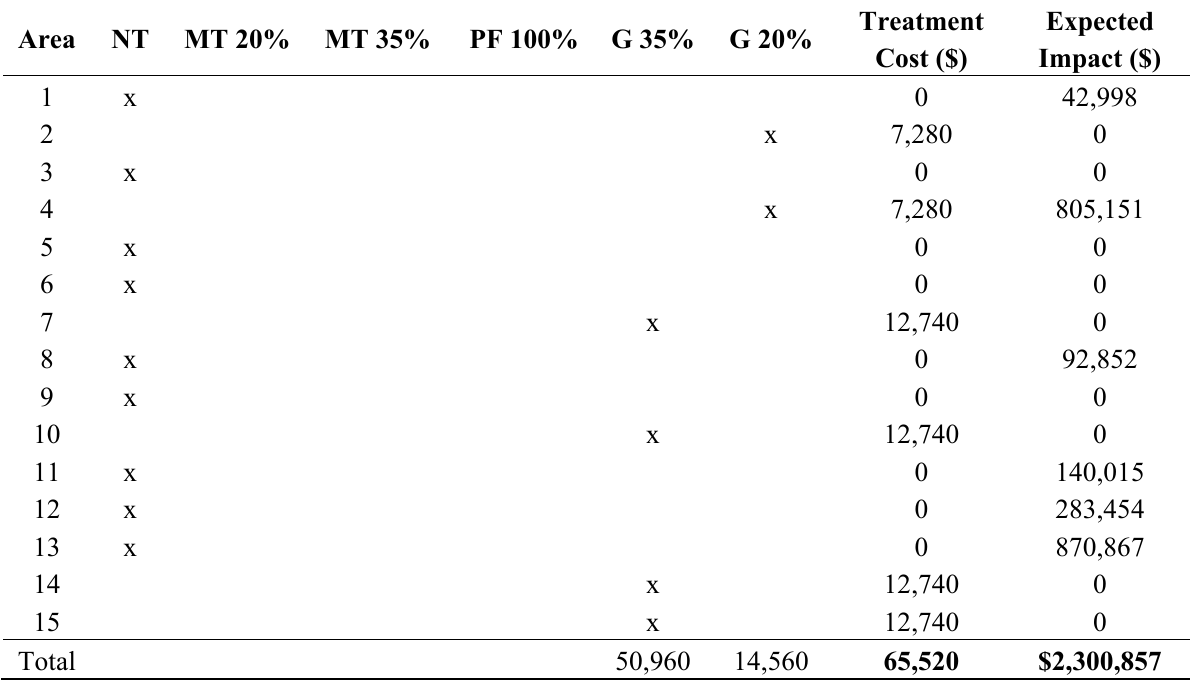
Table 7. Optimal fuel treatment plan based on an ecosystem services factor of 100 and fireline intensity threshold of 1000